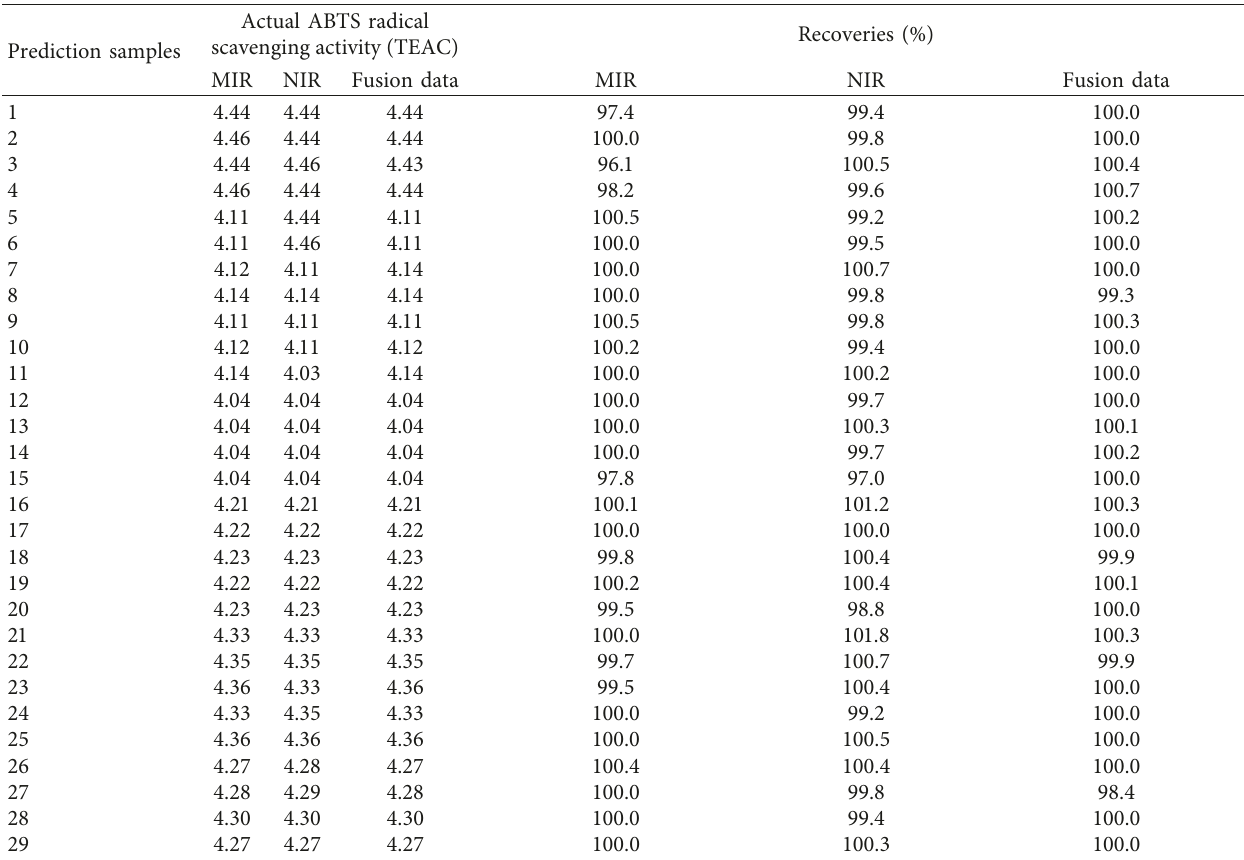
Table 5: The predictions of ABTS scavenging activities by OSWLS-SVM. Prediction